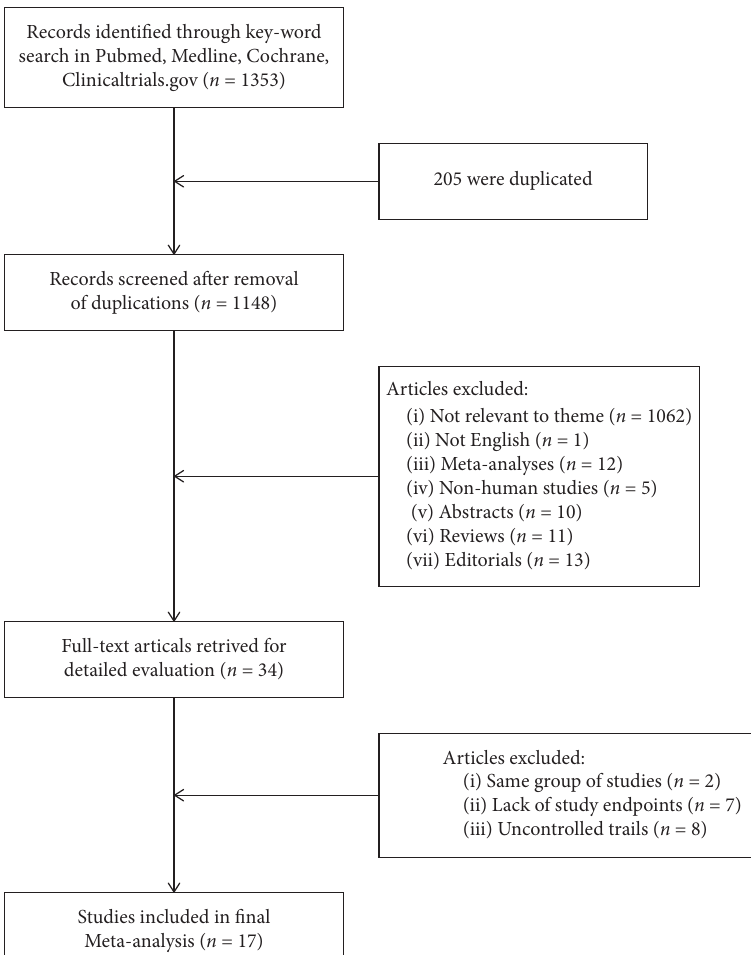
Figure 1: PRISMA flowchart of detailed search